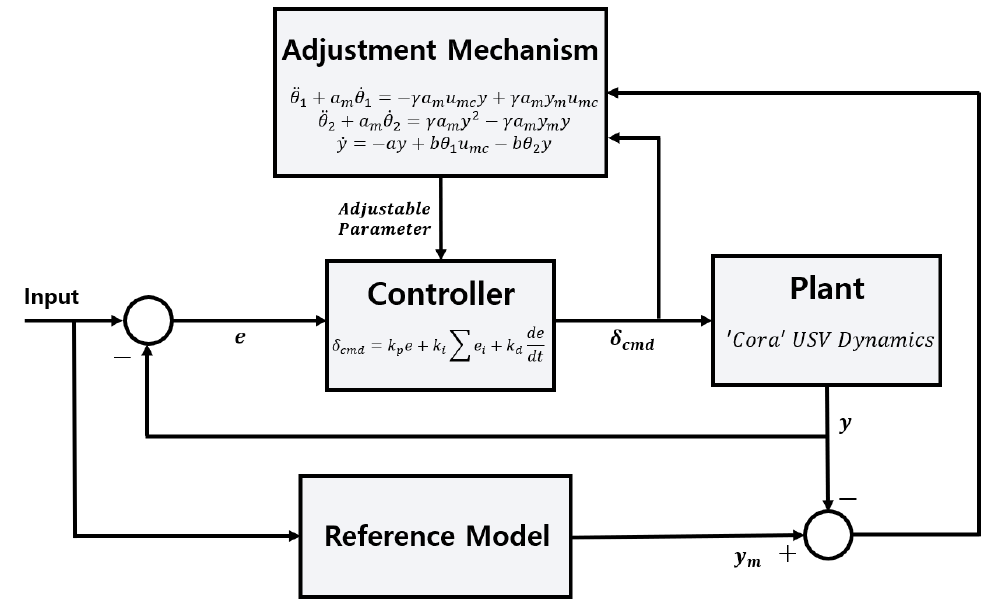
Figure 7. Block diagram of the model reference adaptive control (MRAC) system used in this study.